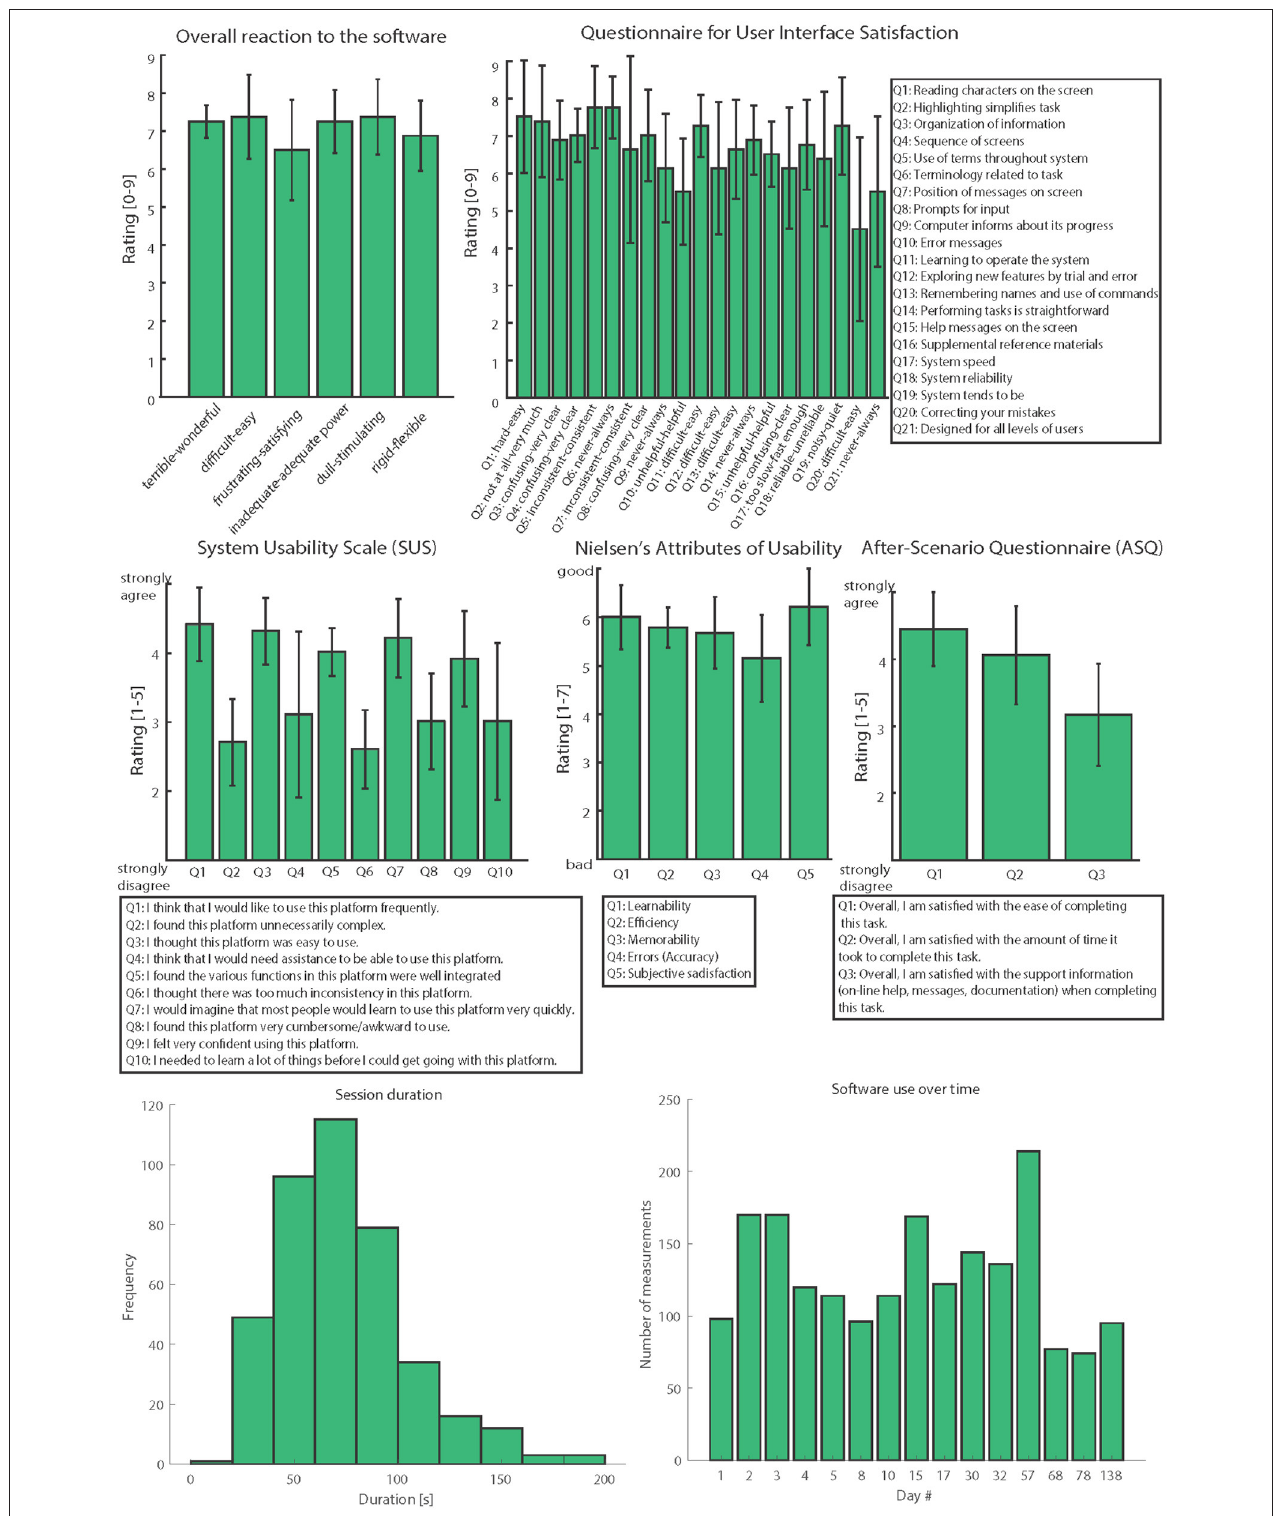
FIGURE 5 | Usability assessment. All the usability scales are reported: Overall reaction to the software, QUIS, SUS, NAU, and ASQ. Three clinicians, six engineers, and three patients evaluated the psychophysical platform ( N = 12). The data in the figure are represented as means ± standard deviations. The last row resumes usage